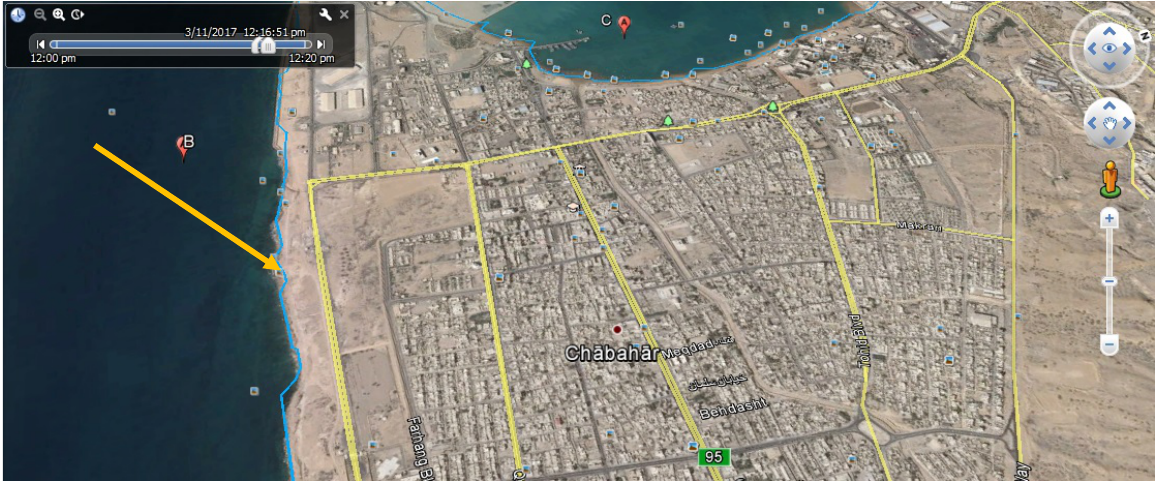
Figure 6. Chabahar port region, blue line shows the coastal line during the tsunami simulation. This photo shows 16 minutes and 51 seconds after tsunami generation. So the boundary of coastal line has no movement caused by the